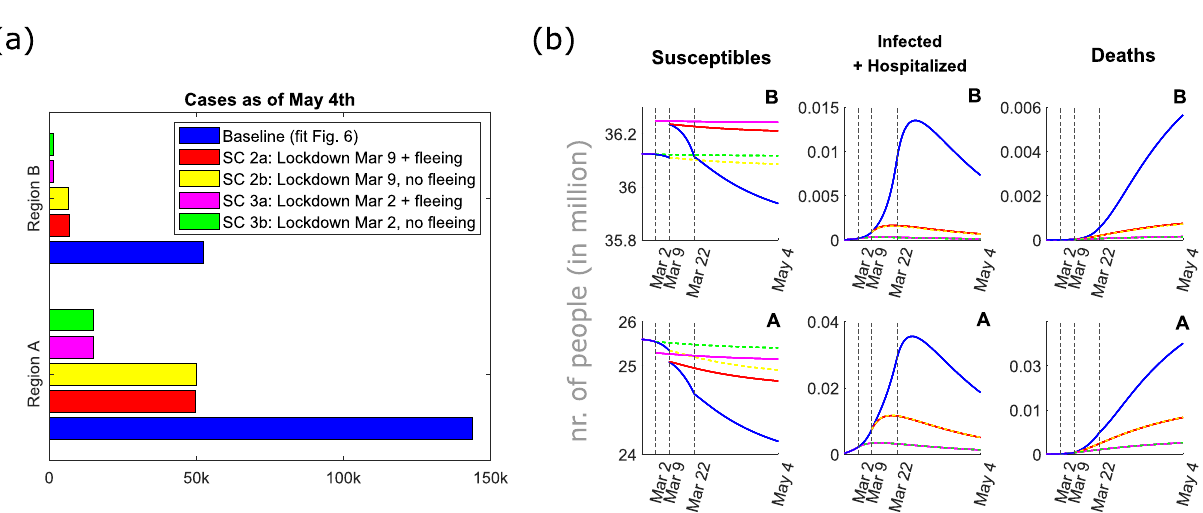
Figure 7. Scenario comparison for ( a ) the cumulative cases of COVID-19 in Italy as of May 4, 2020, and ( b ) evolution in time of susceptibles, detected and hospitalized cases, and deaths until the release of control measures on May 4, 2020. Simulations show the populations in region A and region B for different scenarios: (baseline, blue curves) the setting as of fit in Fig. 6; For all other scenarios severe restrictions (parameter set as of March 22) are in place from the lockdown time: (SC2) lockdown on March 9 (SC2a, red) with and (SC2b, yellow) without fleeing population at lockdown; (SC3) lockdown anticipated to March 2 (SC3a, magenta) with and (SC3b, green) without fleeing population at